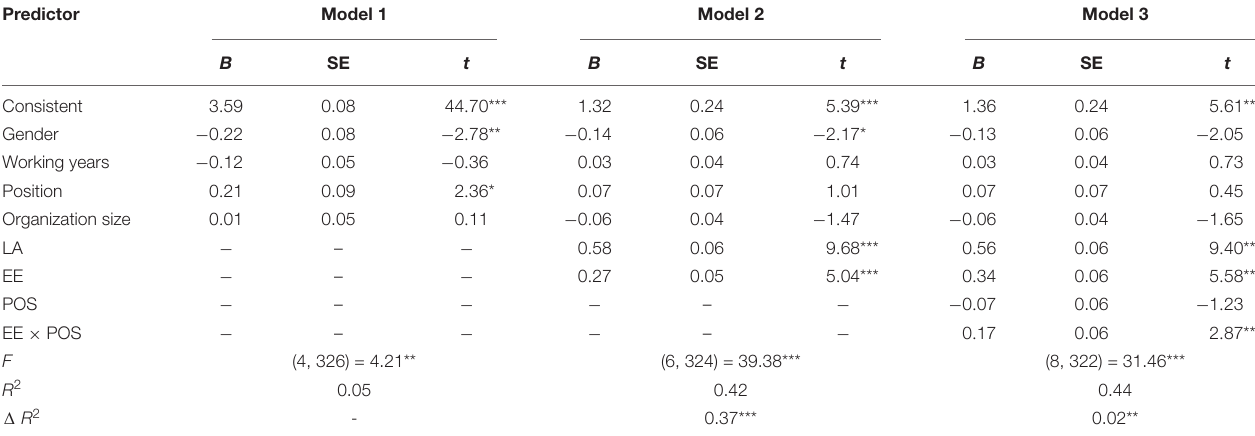
TABLE 3 | Predicting innovative behavior. Predictor Model